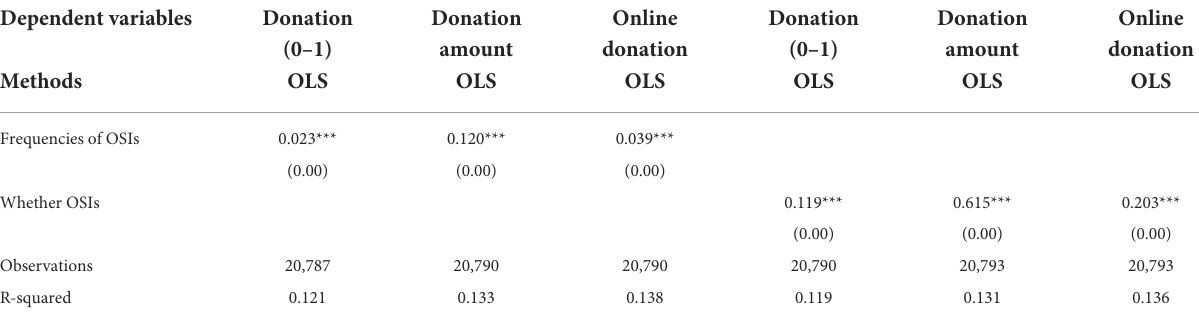
TABLE 3 Associations between OSIs and prosocial behaviors.